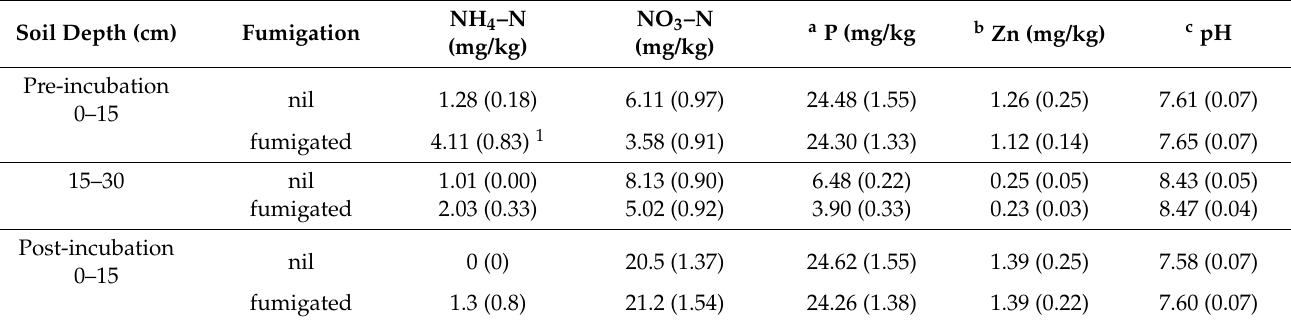
Table 6. Effect of fumigation on soil chemical properties in Experiment 4, before and after incubation for 28 days. Values are the means of n = 15, with SE in parentheses, n = 15.